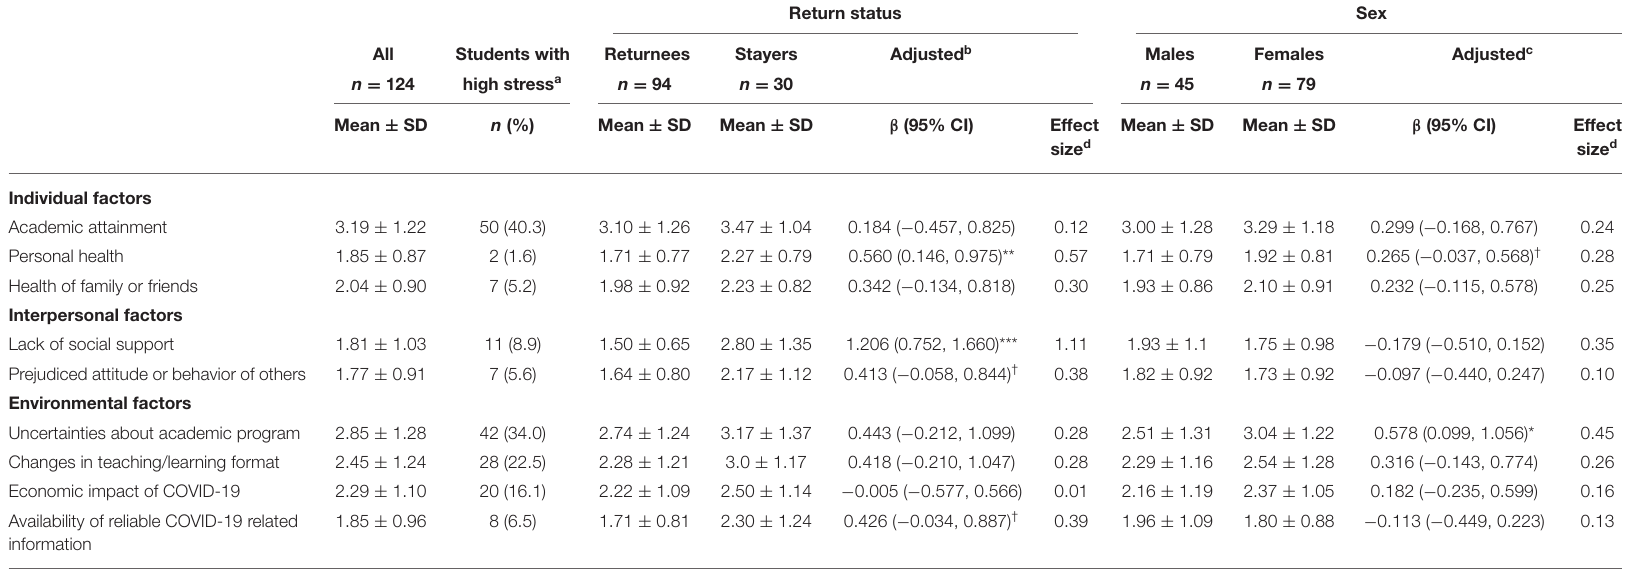
TABLE 2 | Stress levels from coronavirus disease 2019 (COVID-19)-related stressors in the total student sample and